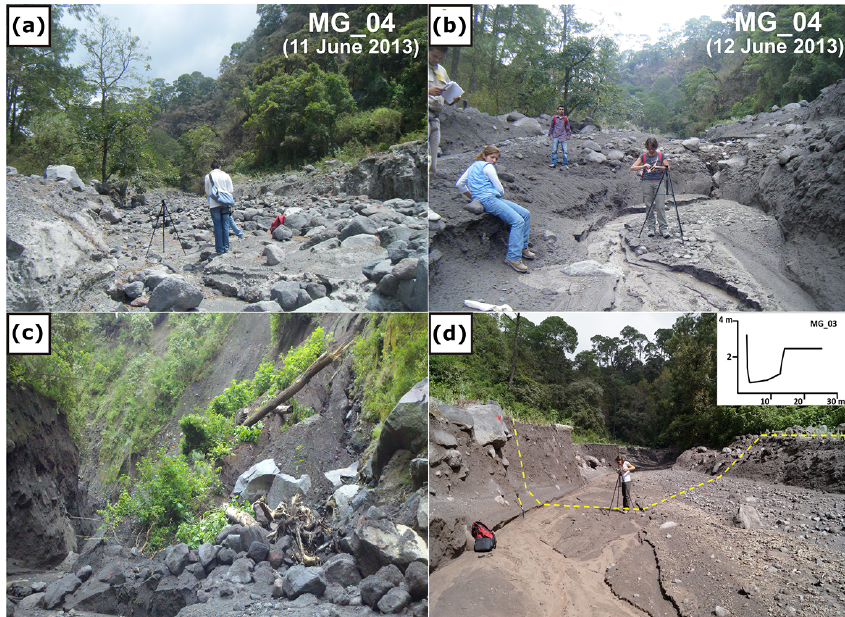
Figure 2. Photographs showing the main morphological features of Montegrande ravine and the changes due to laharic activity. (a) Photo of the morphology at MG_04 checkpoint on 11 June 2013 (at the beginning of the rainy season, and before the development of the lahar) and (b) on 12 June 2013, a day after the lahar, showing the erosion caused by the flow. (c) Trees and debris obstructing the main channel of the ravine during the dry season due to small landslides. (d) Photo of one of the checkpoints, with the sketched profile shown by a hatched yellow line, and the corresponding measured profile.